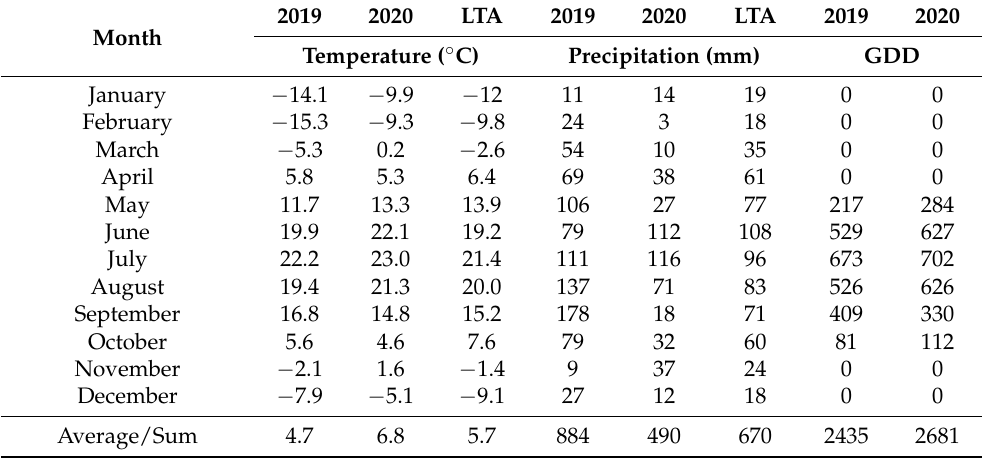
Table 1. Mean monthly air temperature ( ◦ C), total monthly precipitation (mm) and total monthly growing degree days (GDD) in 2019 and 2020 and long-term averages (LTA) at Swan Lake Research Farm, near Morris,